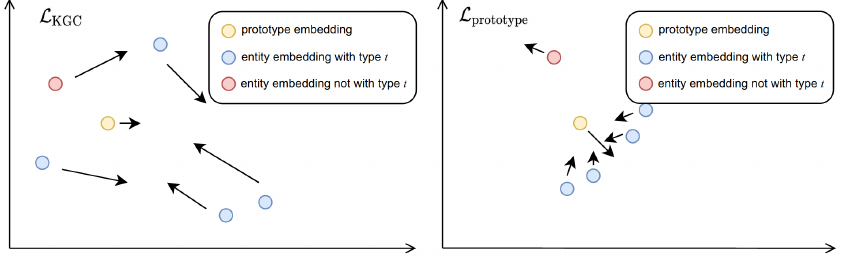
Figure 3. Example of effects of L KGC and L prototype on adjustment of embedding